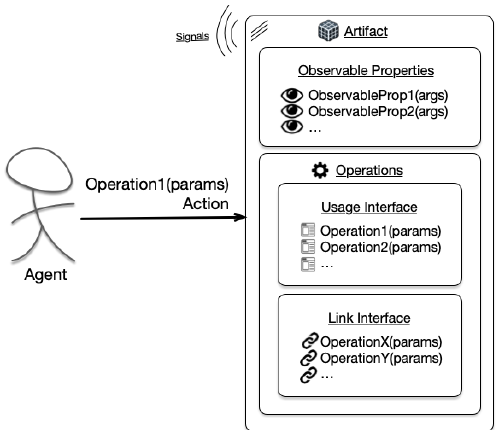
Figure 3. Artifact–agent interaction model: act. As defined in [12].